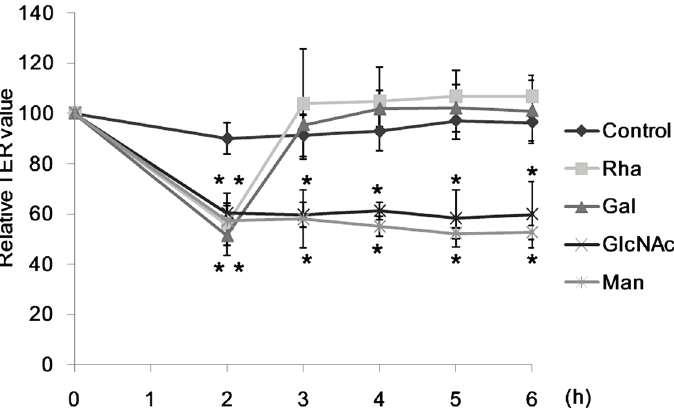
Figure 3. Effects of sugars on TER values after being decreased by CSL3. The Caco-2 cell monolayers were incubated with CSL3 (200 µg/mL) for 6 h. TER values were measured periodically during incubation. After incubation with CSL3 for 2 h, 10 mM sugar was added to the apical side. Results are shown as a percentage of the control (without lectins) values, and are the means ± SD of three different determinations. * p < 0.05 compared with the control value at 2